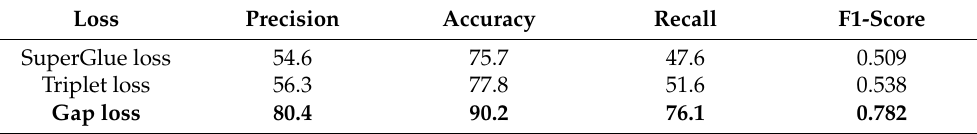
Table 6. Ablation of loss